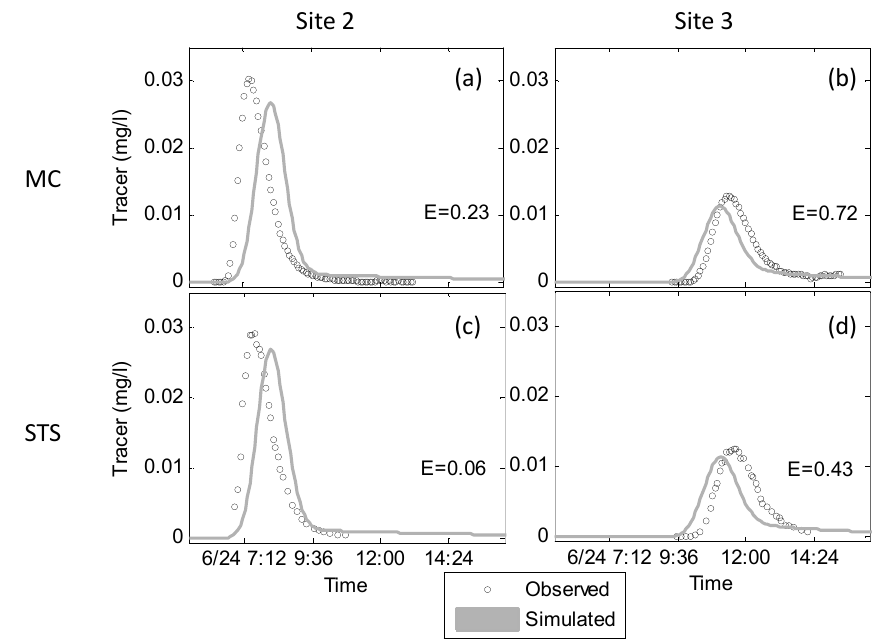
Fig. 4. Test 2 (Level 1) plots of tracer data with results at Site 2 and Site 3 in the main channel (MC) (a, b) , and in the STS (c, d) . E , the performance at each location, is shown in each subplot, observations are shown as a dotted line, and the model simulations are in grey.